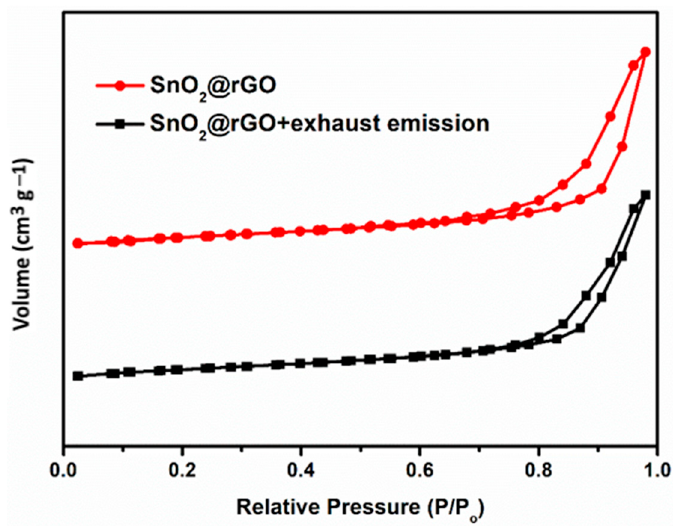
Figure 5. BET-N 2 adsorption-desorption isotherms of SnO 2 @rGO before and after the exhaust emission gas could pass through.